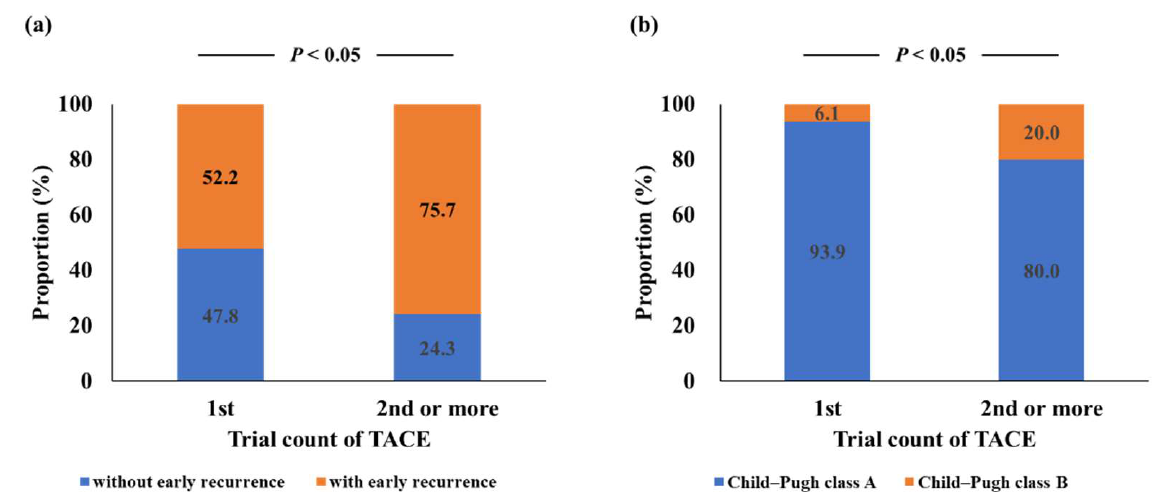
Figure 2. Predicting liver dysfunction after TACE using a combination of ALBI score and PT. The predictive ability of the combination of the ALBI score and PT for liver dysfunction in the transition from Child–Pugh class A to class B after TACE had a specificity of 100%, sensitivity of 91.7%, positive predictive value of 100%, and negative predictive value of 98.8%. ALBI, albumin–bilirubin; PT, prothrombin time; TACE, transcatheter arterial chemoembolization.